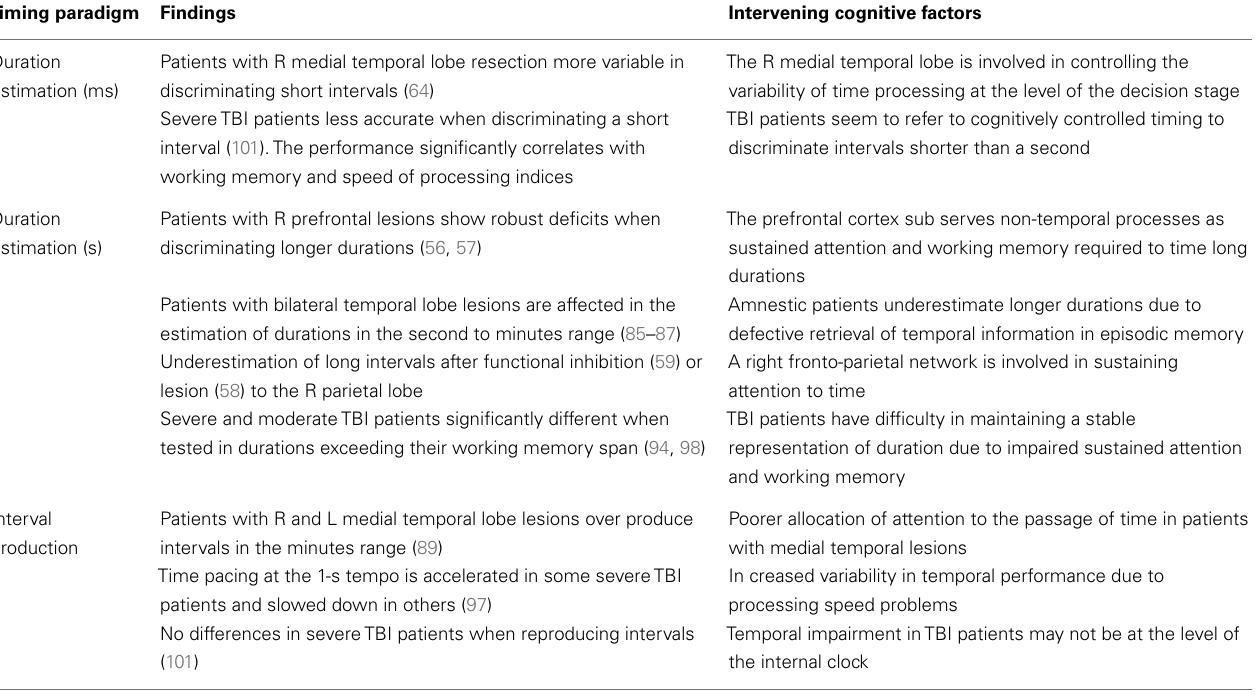
Table 2 | Summary of pathophysiological distortions in time in neurological and traumatic brain injured patients. Timing paradigm